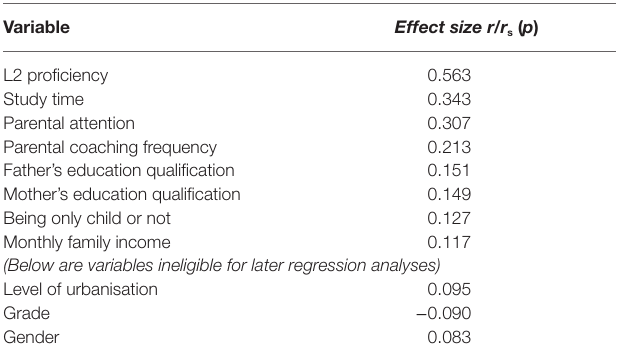
TABLE 3 | Links between the 11 initial independent variables and L2 engagement. Variable